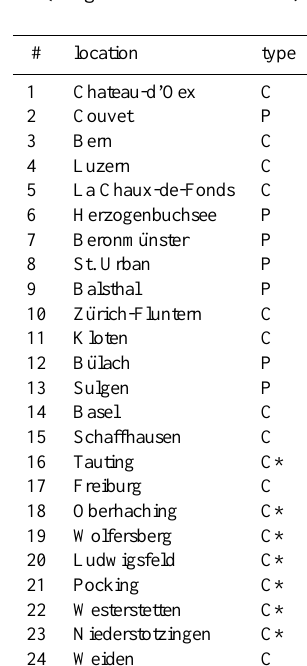
Name and type (P=only precipitation data, C=precipitation and additional meteorological data) of cli- matological stations (* regionalized climate